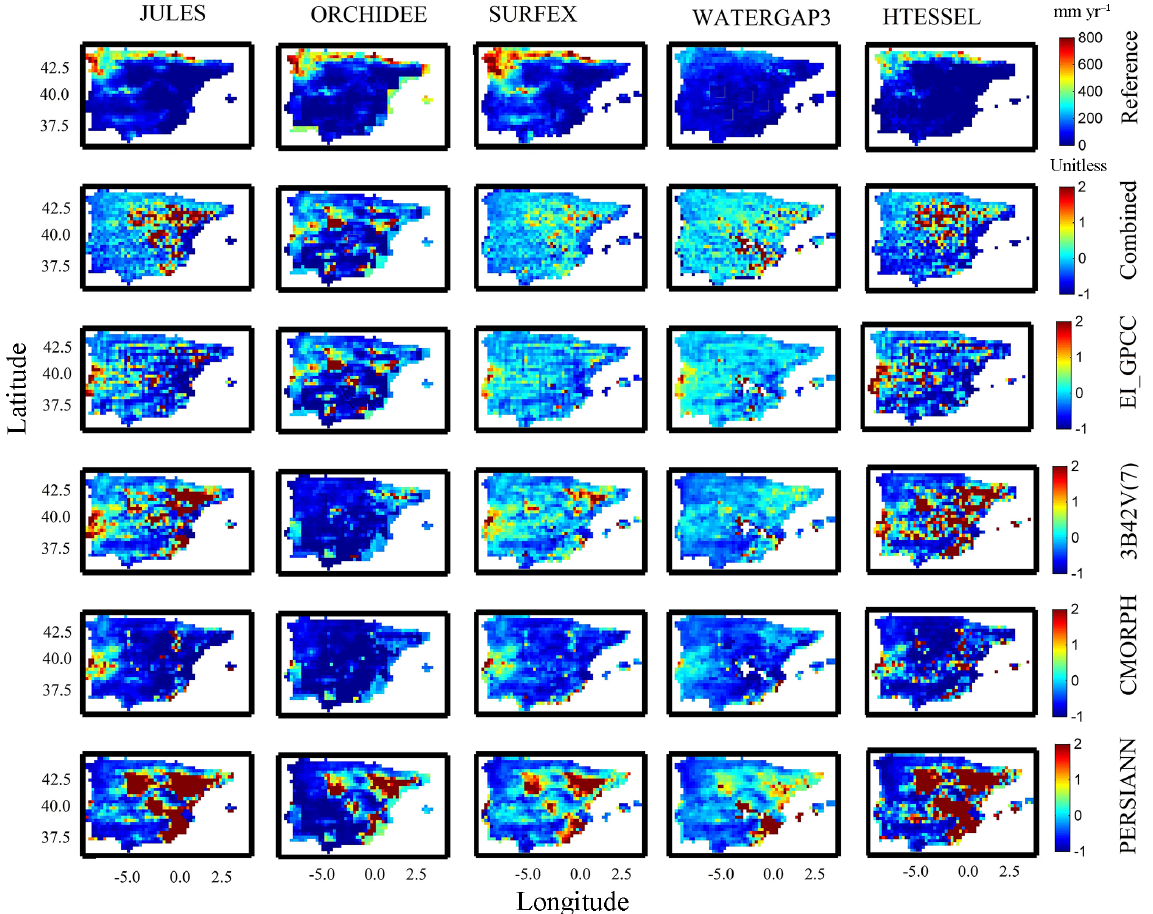
Figure 4. Map of SAFRAN-based simulations (Reference) of subsurface runoff (top row), and relative difference for the various models (columns) and precipitation forcing (rows 2–5)